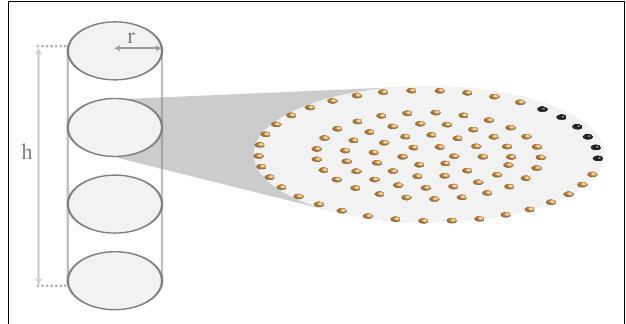
FIGURE 1 | Schematic representation of the cylindrical geometry of the atrial myocyte model. The cylinder has a height of h = 100.4 µ m and a radius of r = 6 µ m. A z-plane transverses the cylinder every 2 µ m along the longitudinal axis. For illustrative purposes, only 4 of the 51 z-planes are displayed.The zoom-in shows the arrangement of the RyRs within a single z-plane. Each small sphere corresponds to a cluster of RyRs.The spacing between RyRs along a ring and between rings of non-junctional Ca 2 + release is 1 µ m.The gap between junctional and non-junctional RyRs is 2 µ m. Please refer to text for the color-coding of the peripheral the